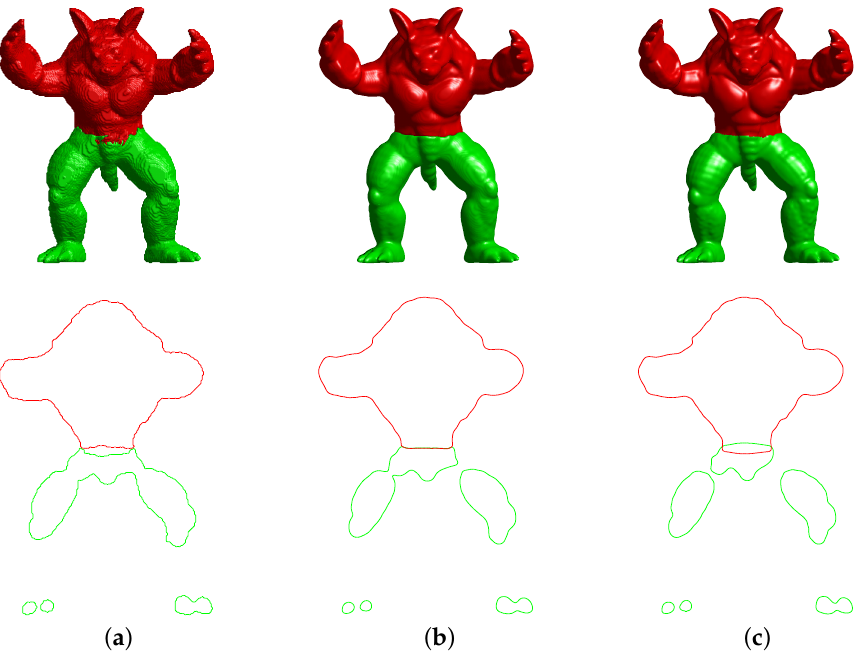
Figure 10. Illustration for the parameter (cid:101) sensitivity analysis. ( a ) (cid:101) = 0.25. ( b ) (cid:101) = 0.75. ( c ) (cid:101) =